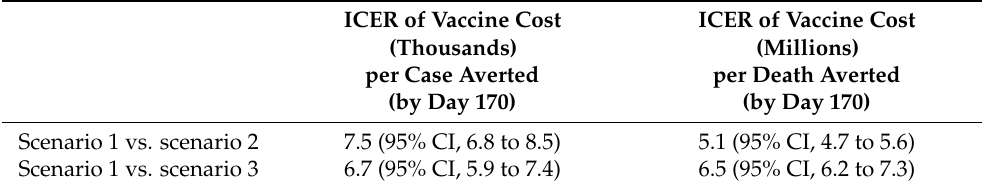
Table 5. ICER of vaccine cost per case averted and death averted by day